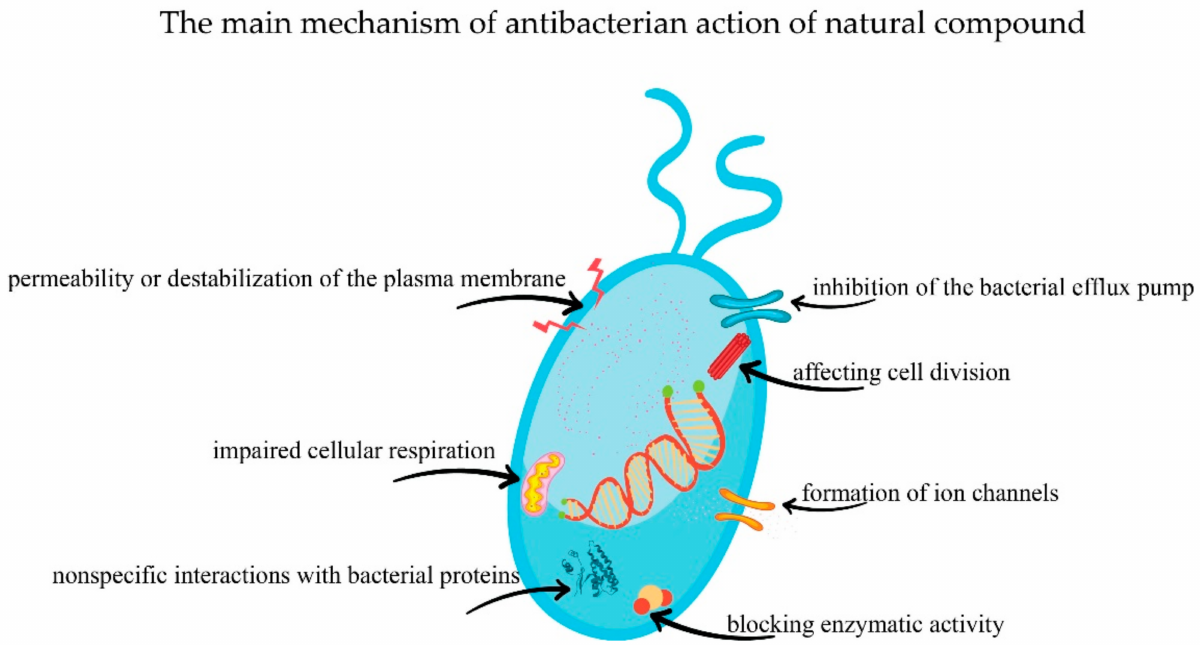
Figure 9. Schematic presentation of the main mechanisms of antibacterial action of